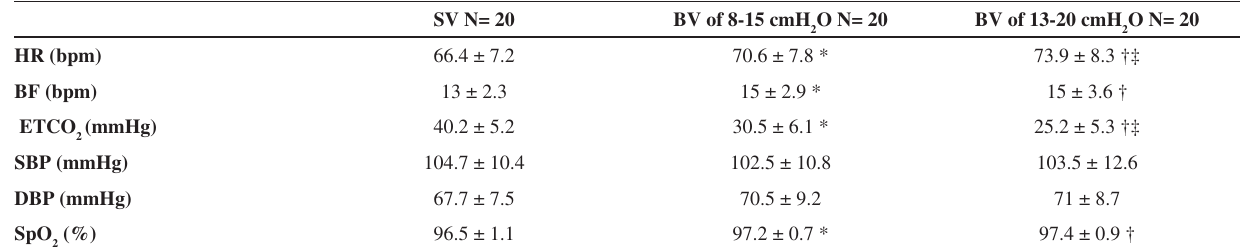
HR= heart rate, presented in beats per minute (bpm); BF= breathing frequency, in breathes per minute (bpm); ETCO millimeters of mercury (mmHg); SBP= systolic blood pressure, in mmHg; DBP= diastolic blood pressure, in mmHg; SpO presented as a percentage; * Bilevel of 8-15 cmH cmH O. Repeated-measures analysis of variance ( ANOVA) with the Tukey post-test. Data expressed in mean and standard 2 Table 2 - Heart rate variability of healthy volunteers during sham ventilation (SV) and Bilevel ventilation (BV)